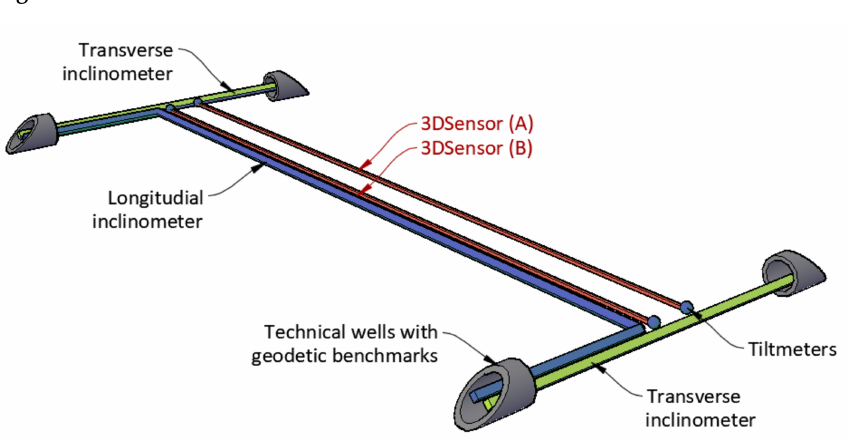
Figure 25. Spatial visualization of the monitoring system with 3DSensors, inclinometers and technical